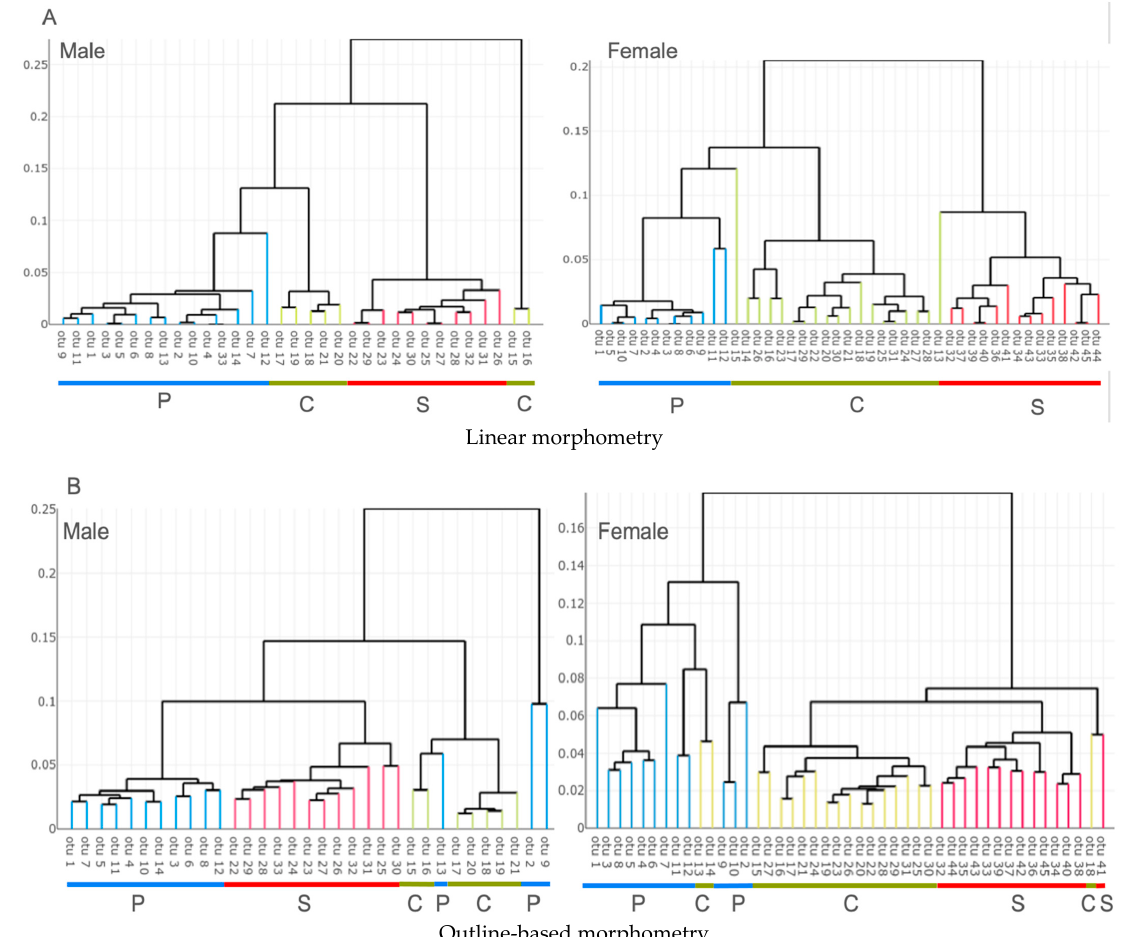
Figure 4. Shape-based hierarchical agglomerative clustering analysis derived from either log-shape ratios ( A ) or normalized elliptic Fourier coefficients ( B ) between males and females. Individuals are plotted on the horizontal axis as operational taxonomic units (OTU). Capital letters P, C, and S in- dicate the affiliated species, as to Paracimex sp. (P), Cimex hemipterus (C), and Stricticimex parvus (S). In outline-based morphometry, the formation of three groups that corresponded to their re- spective species was also prominent in both males and females (Figure 4B). However, in males, the Paracimex group was split into two separated clusters, plus one individual that was found in the Cimex cluster (Figure 4B). Some female Cimex were found either in the Paracimex (two individuals) or the Stricticimex (one individual) clusters (Figure 4B). Thus, the unsupervised classification using the outline-based approach clustered 91% (30/33) of males and 93% (42/45) of females in agreement with the pre-established groups.